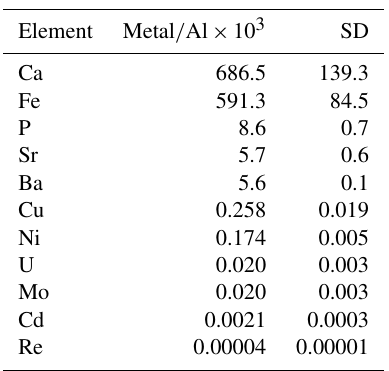
Table 3. Concentration of elements in the Pachingo wetland sedi- ments, considered as lithogenic background for the study area. The values correspond to mean concentrations in the surface sediments